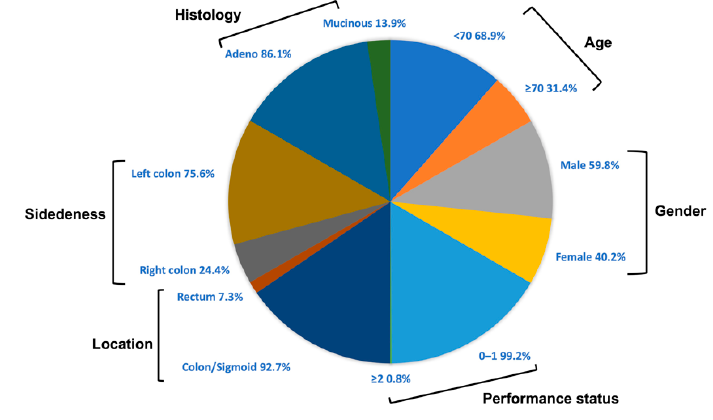
Figure 1. Patients’ characteristics. Table 1. Patients and healthy controls characteristics.